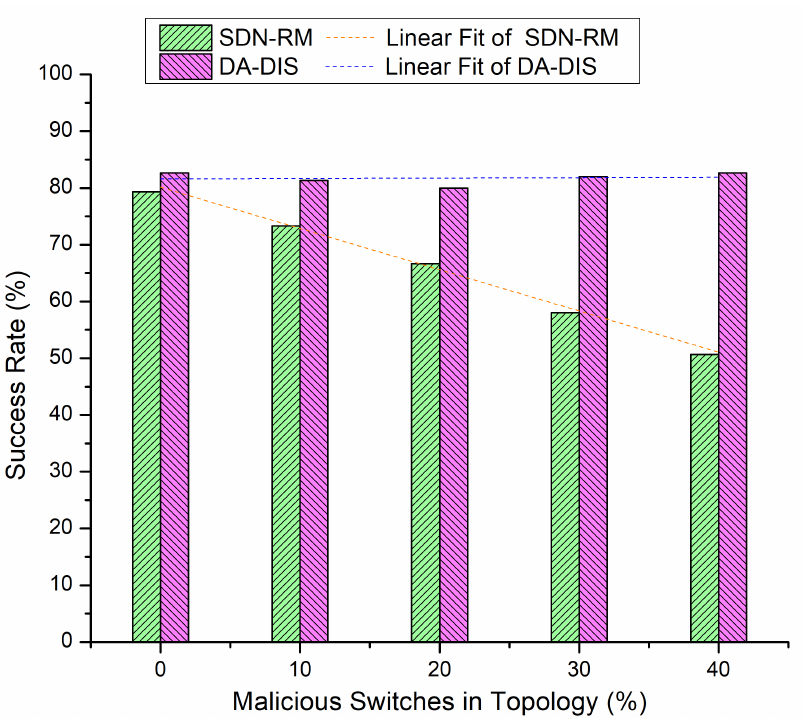
Figure 11. Success rate considering different numbers of malicious switches with E1 and E2 cate- gory faults.